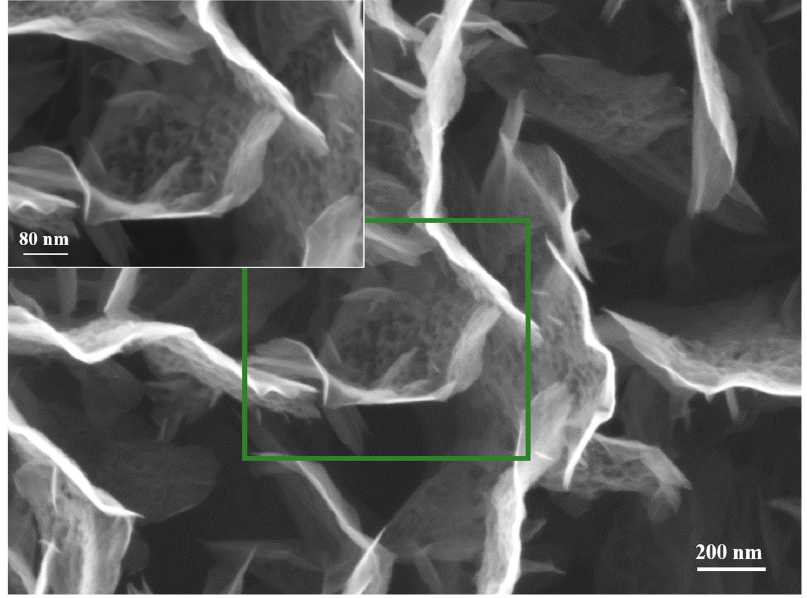
Figure 7. CNW after thermal treatment (No powder source) (600 degrees, plasma off).